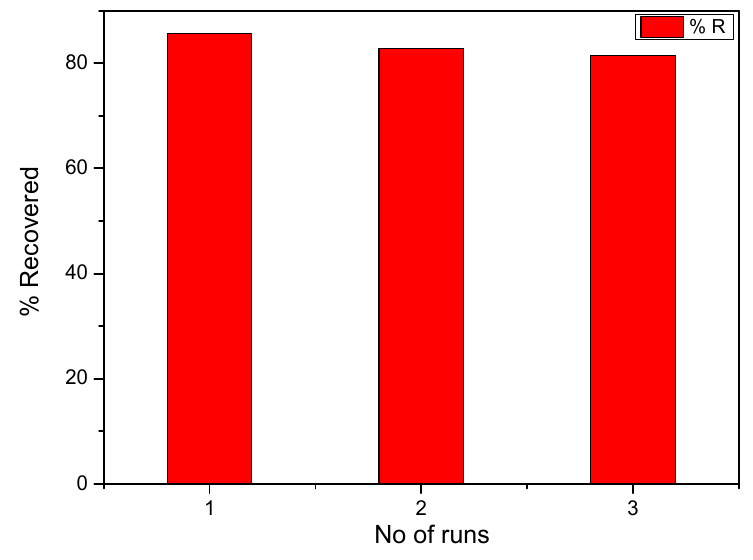
Figure 6. Recovery plot of Pb(II) ions from Fe 3 O 4 @yeast / EDTA composite after three cycles [64]. Table 3. Adsorptive properties of selected magnetic nanocomposites for wastewater treatment.